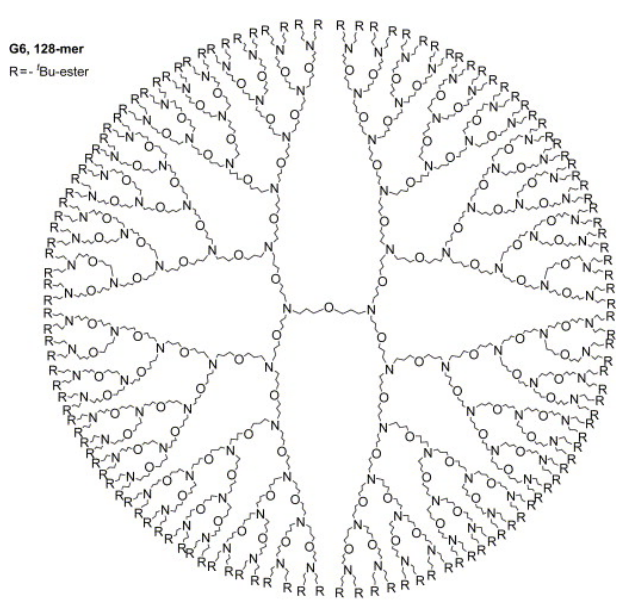
Figure 2. Zinc Prophyrin Dendrimer DPZ n